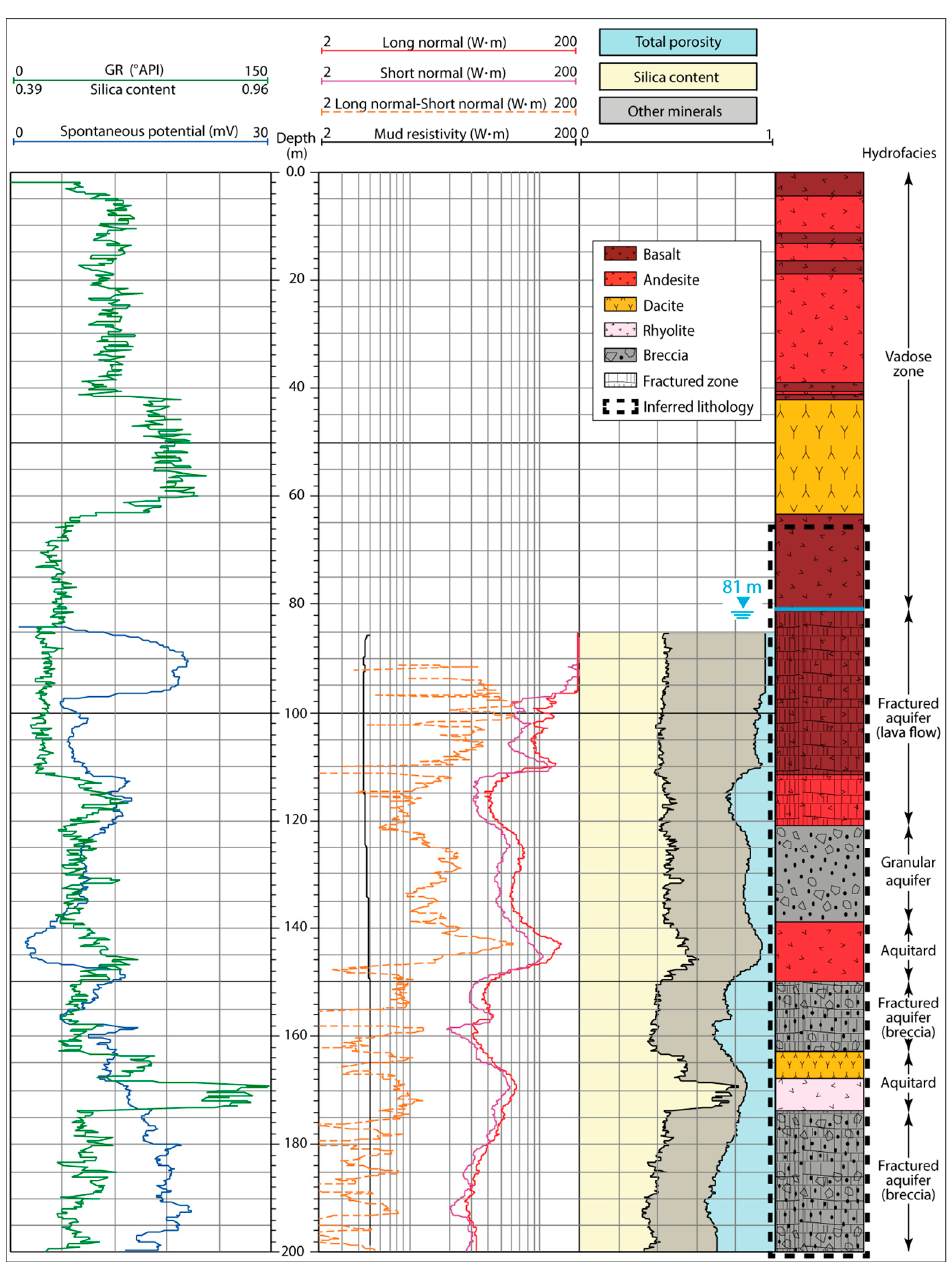
Figure 4. Geophysical logs acquired during drilling, reconstructed lithology and inferred vertical hydrofacies. GR: Gamma Ray; API: American Petroleum Institute.